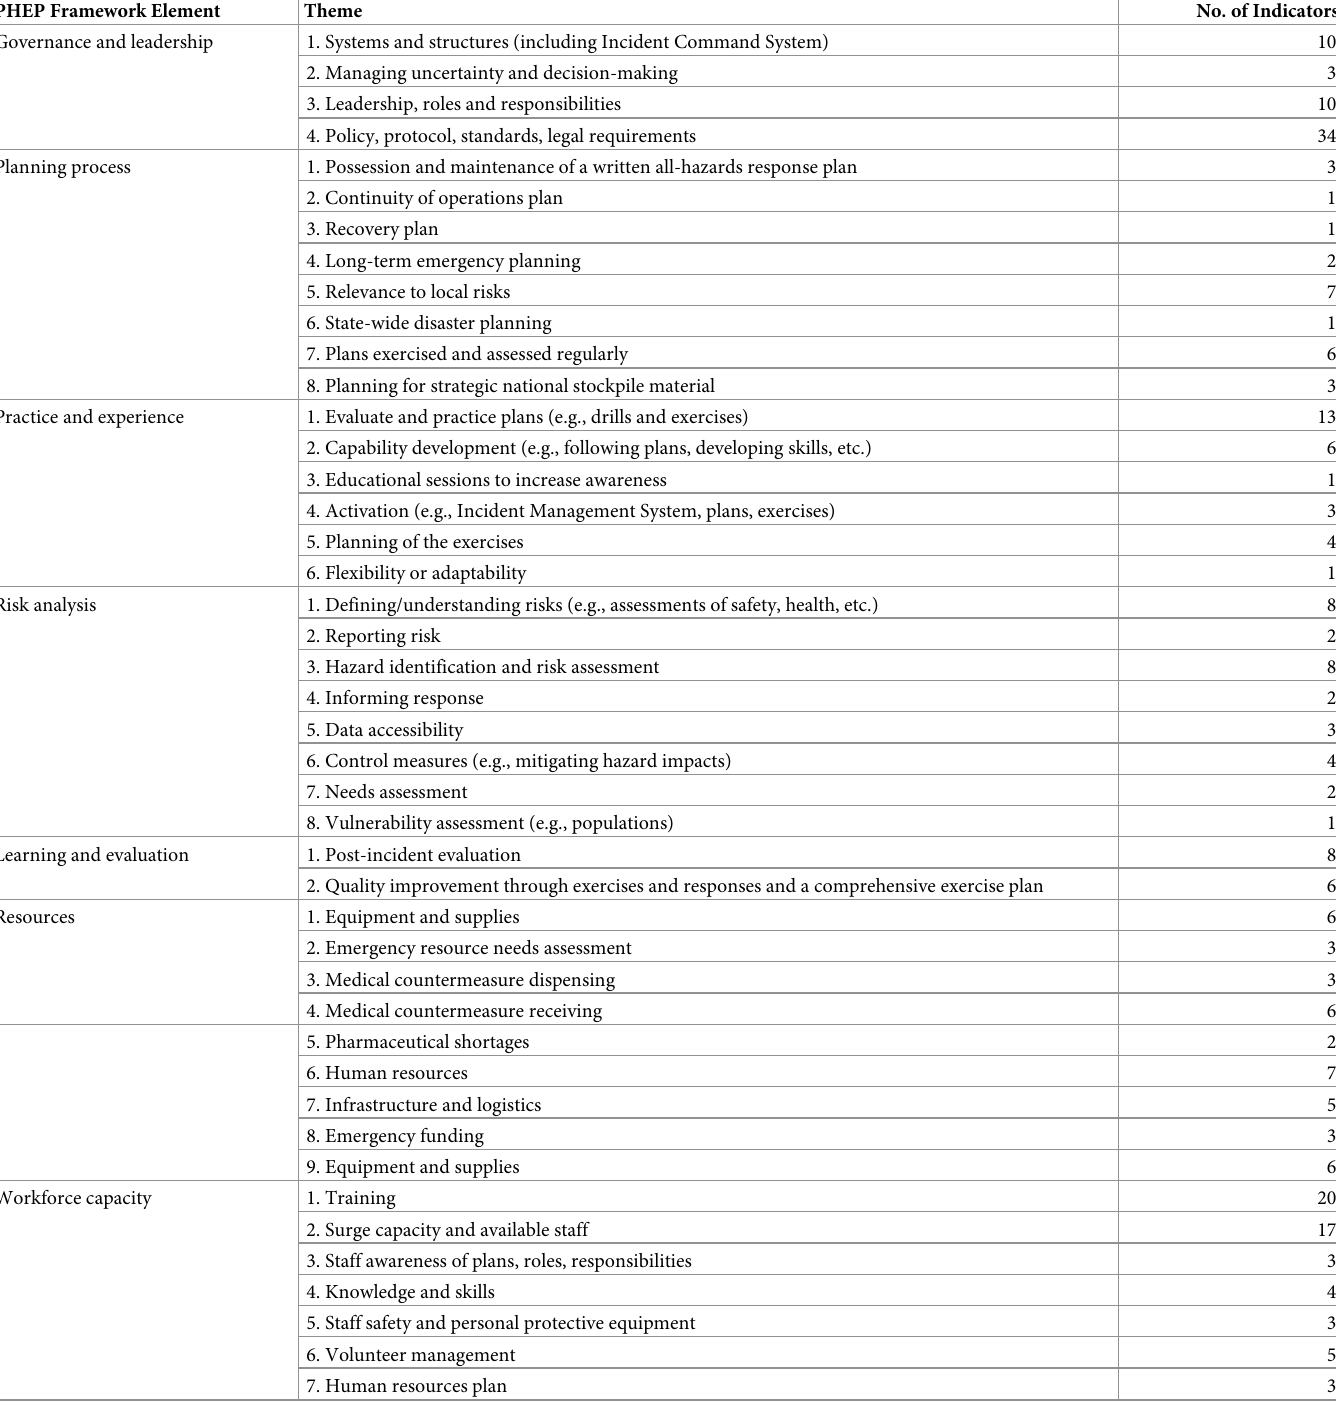
Table 2. Public health emergency preparedness framework and indicator